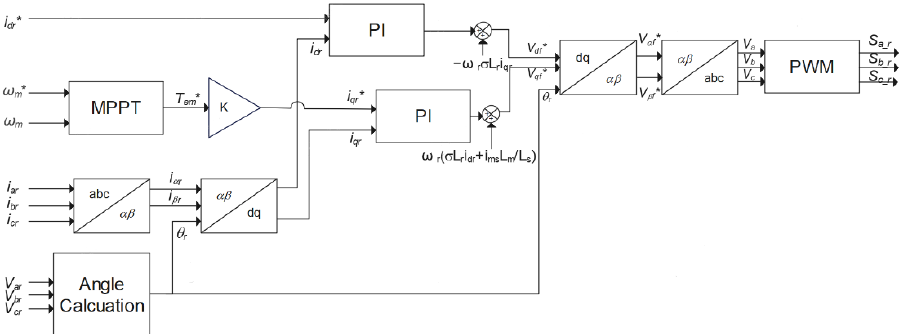
Figure 8. Proposed controller of rotor side converter.